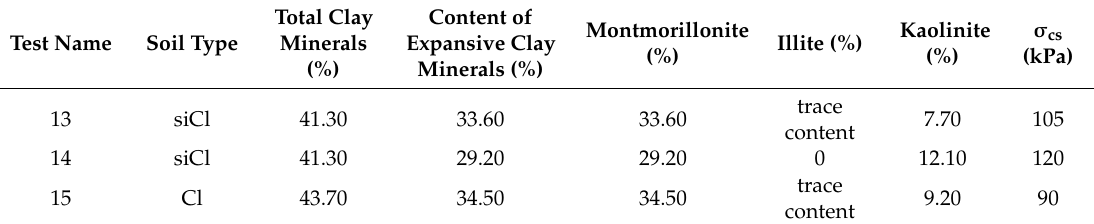
Table 4. Expansiveness characteristics of tested